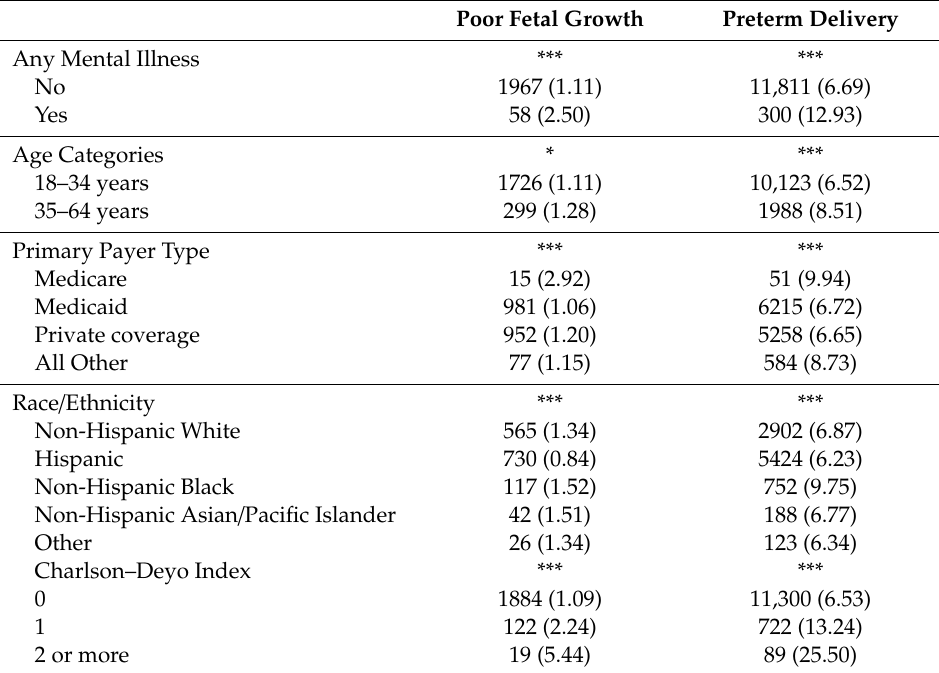
Table 1. Prevalence of neonate outcomes among study variables in the South East Desert / Inland Empire region of California, OSHPD 2008–2010. Total sample size n = 178, 737 † . Poor Fetal